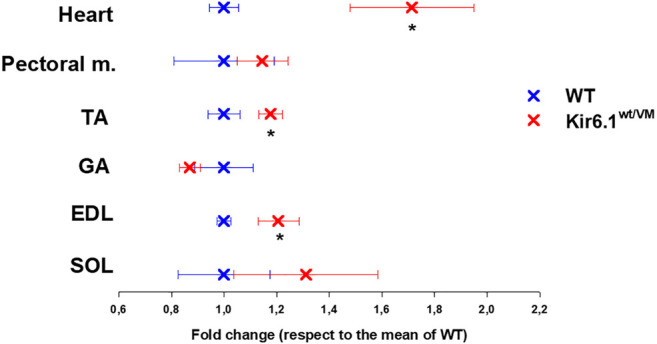
Organ weight differences between WT and Kir6.1wt/VM mice. A tendency toward higher organ weight is observed in Kir6.1wt/VM mice. Values are presented as mean ± SEM (n. mice = 4 for WT and Kir6.1wt/VM); organ mean weights are normalized by the control mean. No differences were found in terms of weight among right and left muscles. GA, Gastrocnemius; TA, Tibialis anterior; EDL, Extensor digitorum longus; SOL, Soleus; PECTORAL M., Pectoral muscles. *Data significantly different within groups and between groups was evaluated by one WAY ANOVA with calculated F values > 1.3 (p < 0.05).